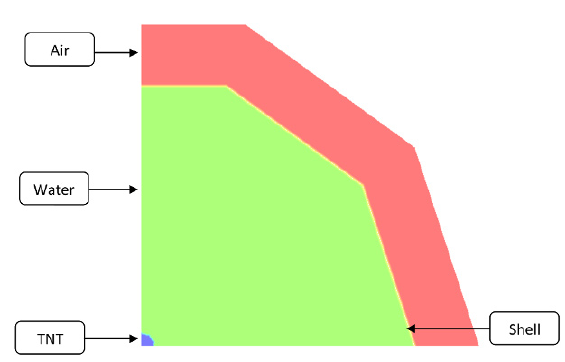
Figure 7. Model adopted in LS-DYNA software.